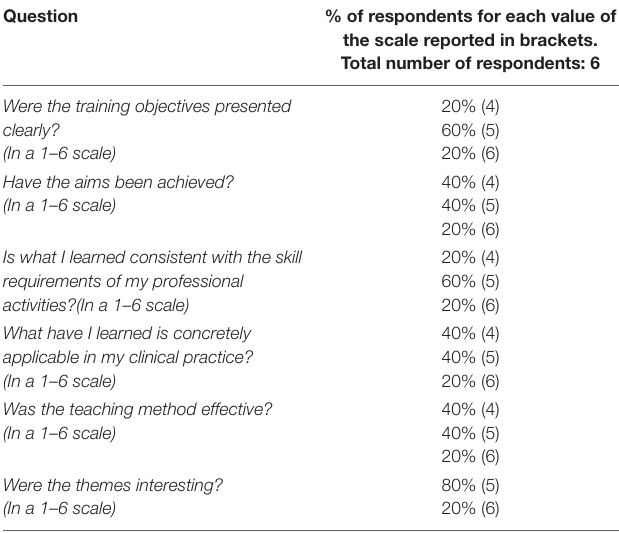
TABLE 4 | Results of the satisfaction questionnaires.